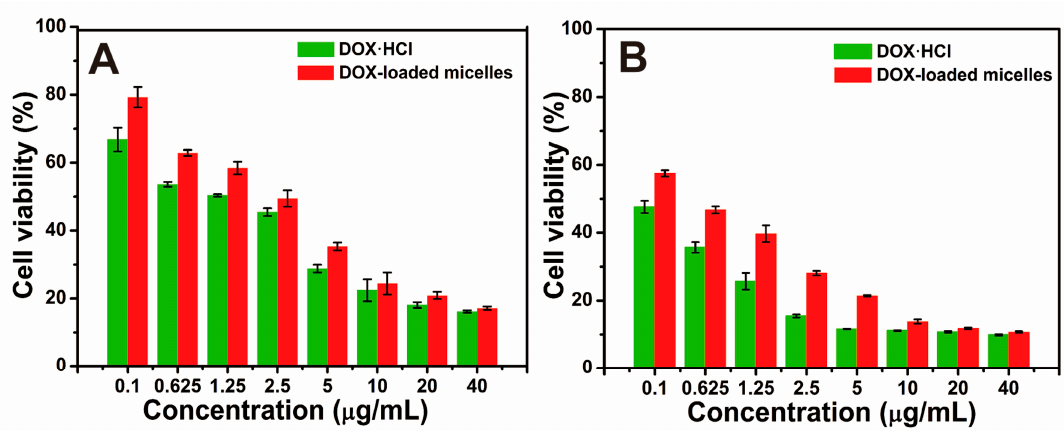
Figure 5. Viability of HeLa cells incubated with various concentrations of DOX / pseudopolyrotaxanes micelles and free DOX·HCl for 24 h ( A ) and 48 h ( B ). (The concentration of DOX is 10 μ g/mL).